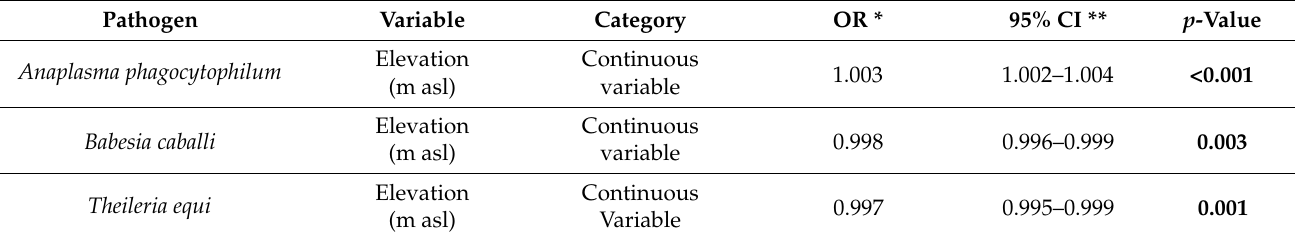
Table 3. Potential risk factors associated with Anaplasma phagocytophilum , Babesia caballi and Theileria equi seropositivity in horses reared in northern Italy by univariate analysis. Test performed at a 95% significance level. Note: p -values ≤ 0.1 considered